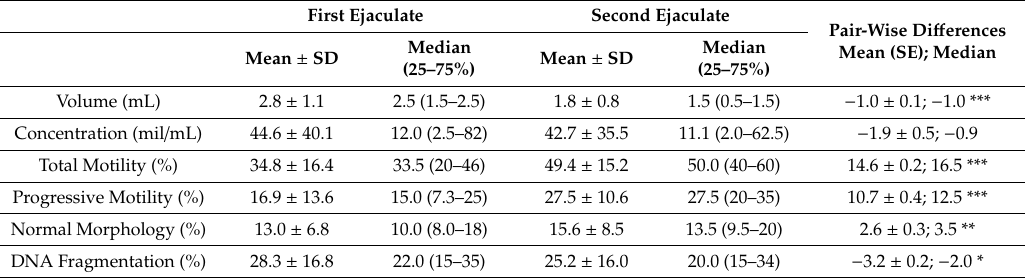
Table 2. Seminal fluid volume, conventional sperm parameters and DNA fragmentation of the two ejaculates in patients with oligo-astheno- and / or terato-zoospermia ( n =